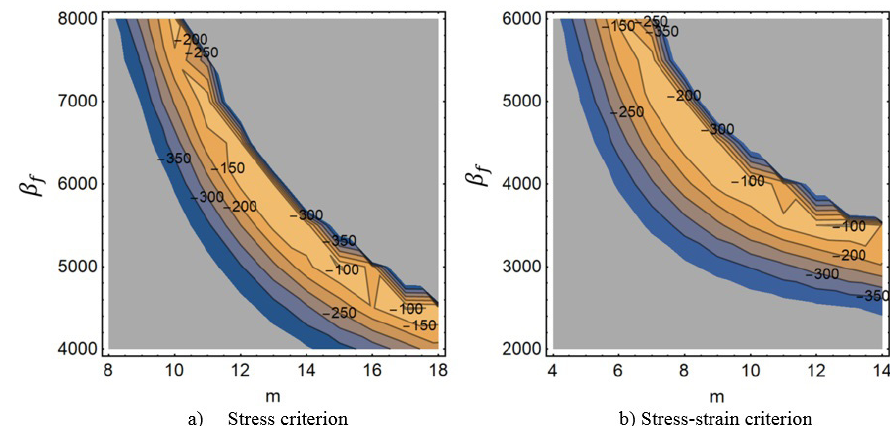
Figure 8. Likelihood pattern for local fracture